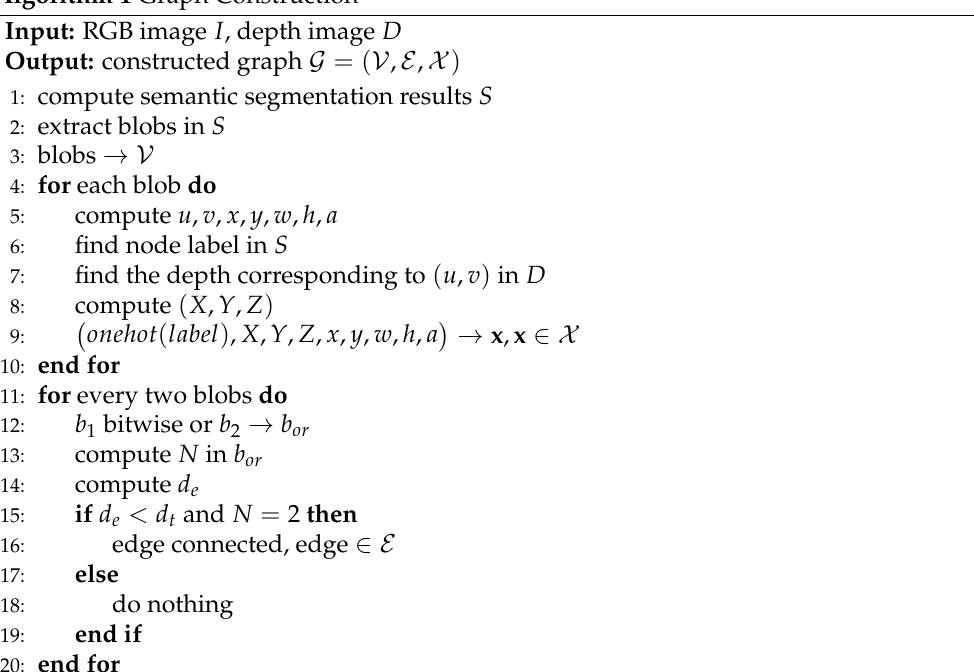
Algorithm 1 Graph